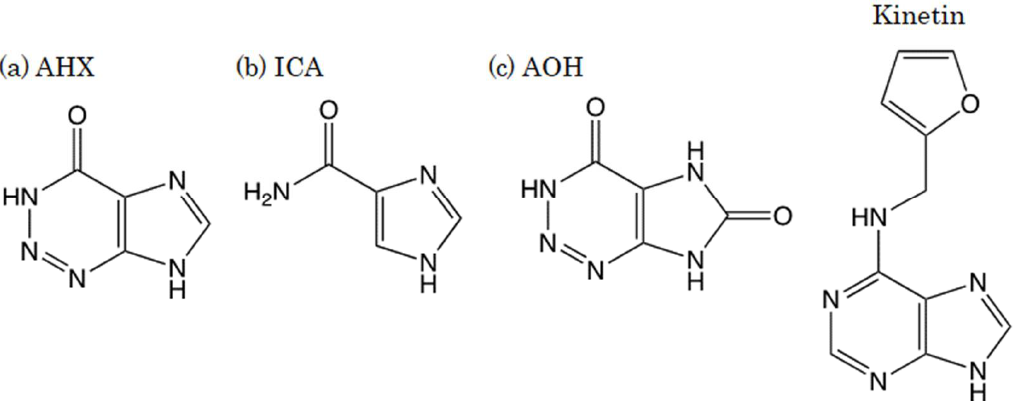
Figure 2. Structures of ( a ) 2-azahypoxanthine (AHX), ( b ) imidazole-4-carboxamide (ICA), ( c ) 2-aza-8-oxohypoxanthine (AOH), and kinetin.